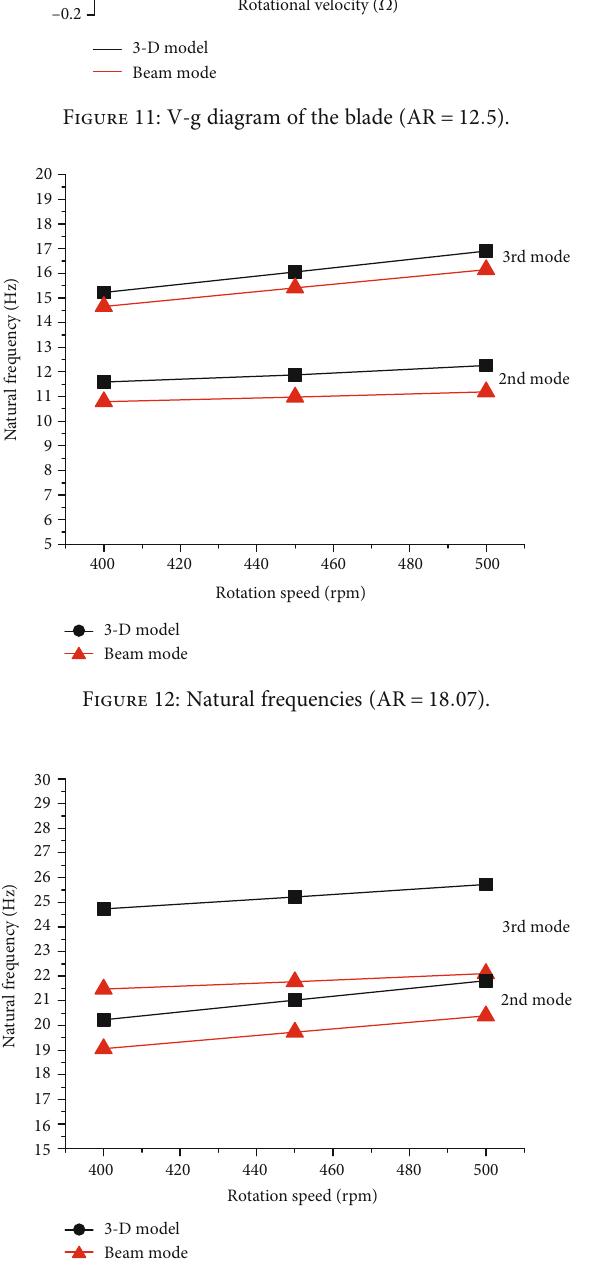
Figure 13: Natural frequencies ( AR = 12 : 5